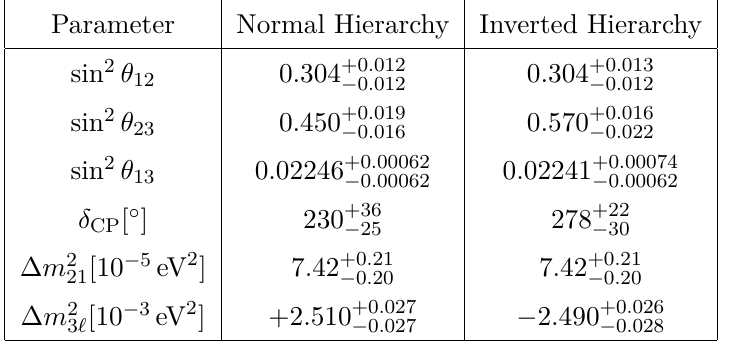
Table 1 . The best fit of the neutrino oscillation parameters with 1 σ range [111, 112]. ∆ m 2 for NH and ∆ m 2